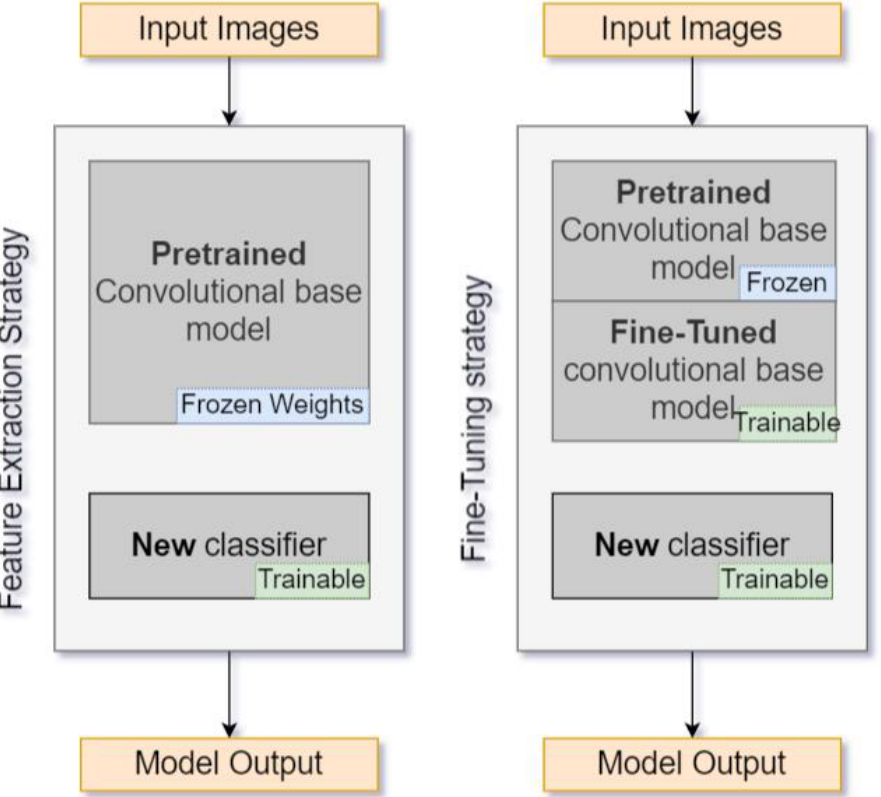
Figure 5. Transfer learning feature extraction ( left ) and fine-tuning ( right ) training approaches diagram. In the feature extraction approach, the base model’s weights remain frozen and only the classifier is trained, while in the fine-tuning approach, training occurs in both of the last few layers of the base model (“Fine-Tuned convolutional base model” in the figure) and the classifier. Another scenario scheme concerns the kind of classifier that can be used as a TL ap- proach in the last layer of the deep neural architectures that are selected. The proposed ar- chitectures considered applying either a 3-layer neural network or a 4-layer neural